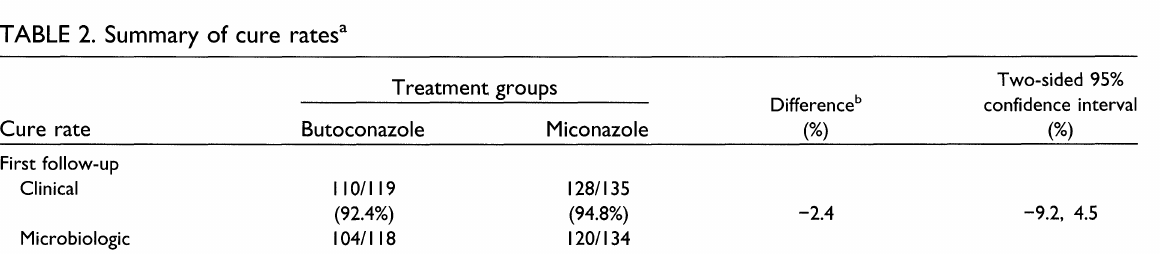
TABLE 2. Summary of cure rates Cure